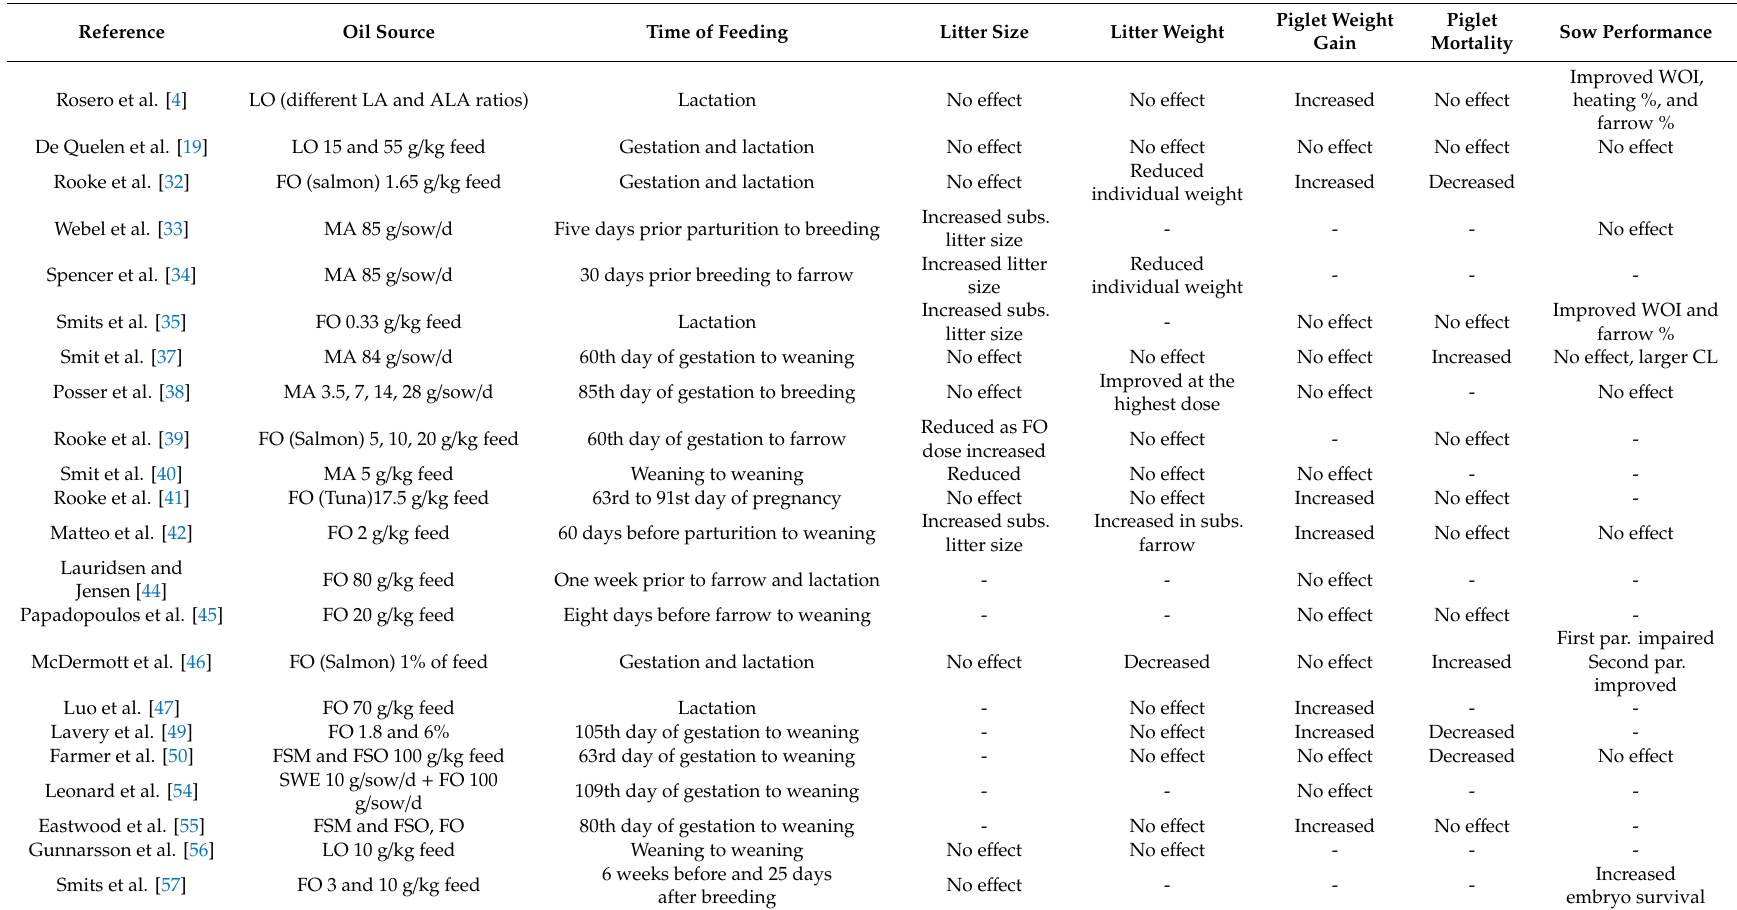
Table 1. E ff ects of n-3 long-chain PUFAs on performance parameters of sows and their